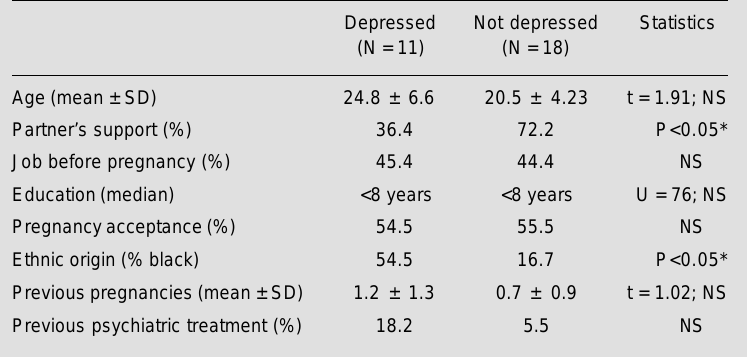
Table 2 - Background and social factors associated with postnatal depression as assessed by the Edinburgh Postnatal Depression Scale in low income